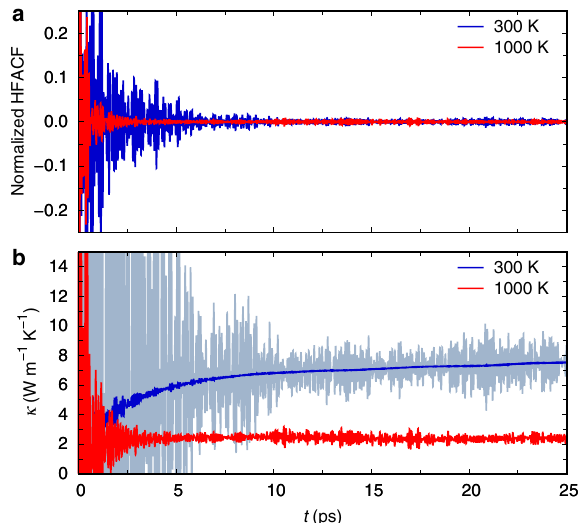
Fig. 5 Calculating the thermal conductivity using GK theory. a Heat- fl ux autocorrelation function (HFACF) normalized by its zero- time value and b thermal conductivity as a function of correlation time at T = 300 K and 1000 K. In b the moving average of κ over blocks of 1000 time steps is shown on top of the raw data at T = 300